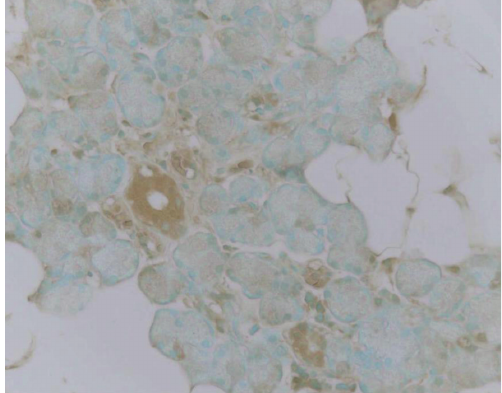
Figure 2: Showing strong p53 staining in pleomorphic salivary adenoma. Original magnification x40.